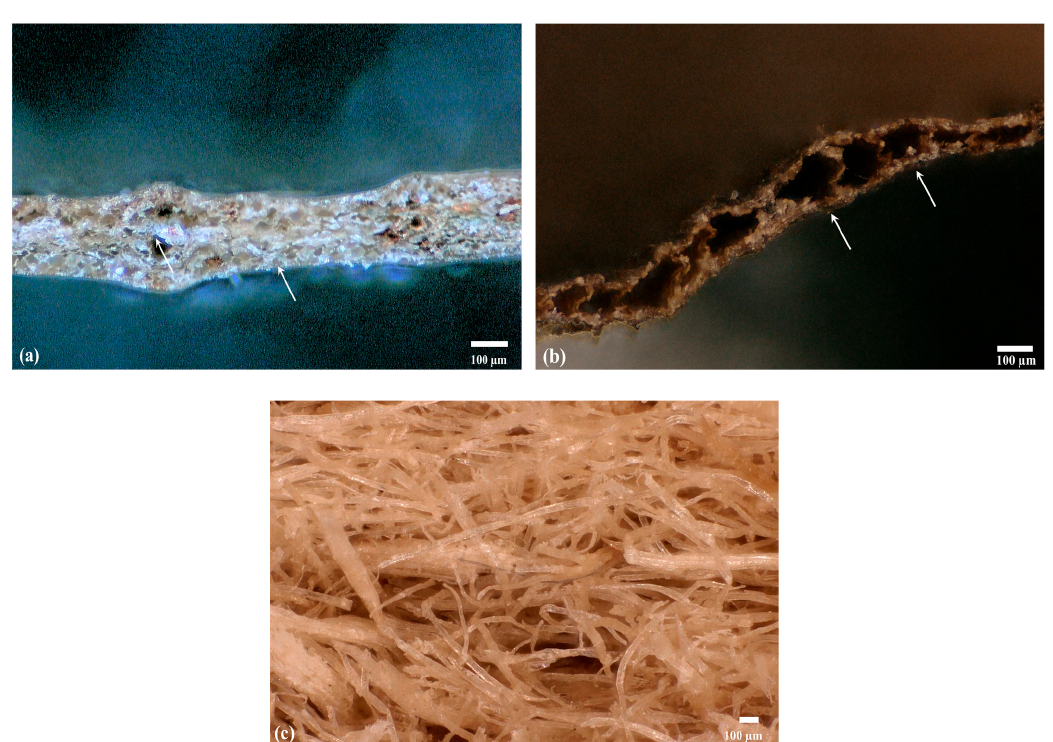
Figure 3. Microscopy images showing the internal structure of seagrass leaves. Cross-section view of Posidonia oceanica seagrass ( a ), Zostera marina seagrass ( b ), and wood fibers ( c ). The white arrows indicate the porous structure of leaves (closed cells).